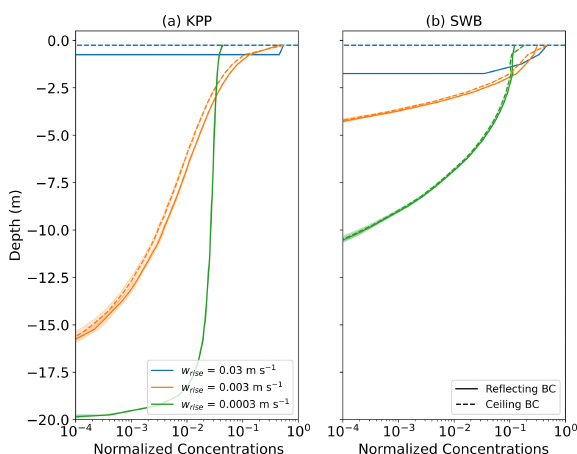
Figure G1. Vertical concentrations of buoyant particles for (a) KPP and (b) SWB diffusion using M-0 models for reflective and ceiling BCs. Shading around the profiles indicates the profile’s standard deviation at each depth level. All profiles are for u 10 = 6 . 65ms − 1 . The KPP profiles are computed with θ = 1 . 0 and z 0 according to Eq. (12), while the SWB profile is computed with γ = 1 . 0.